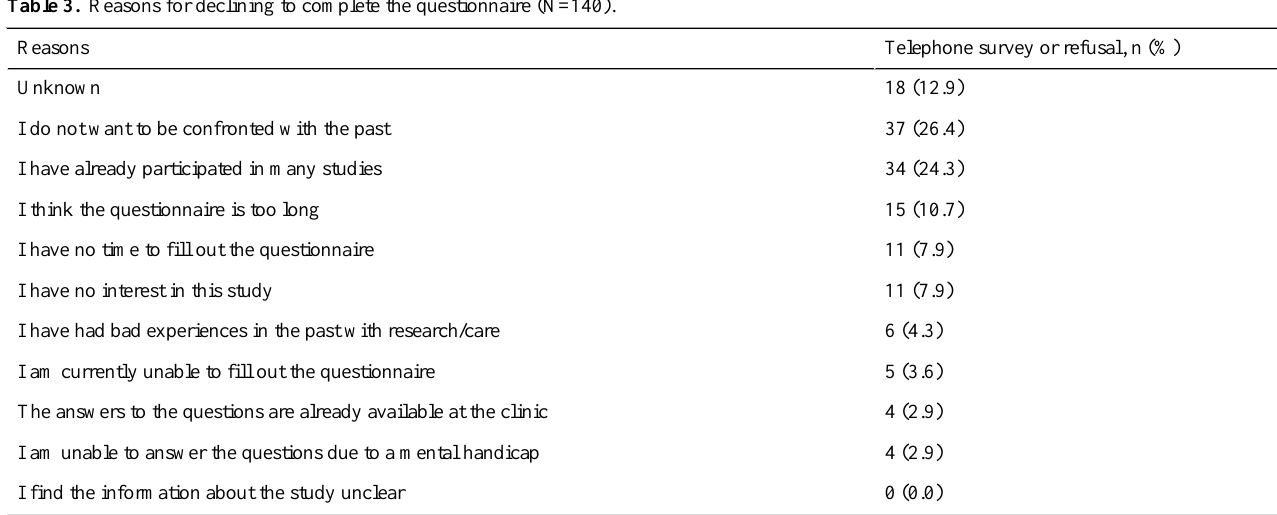
Table 3. Reasons for declining to complete the questionnaire